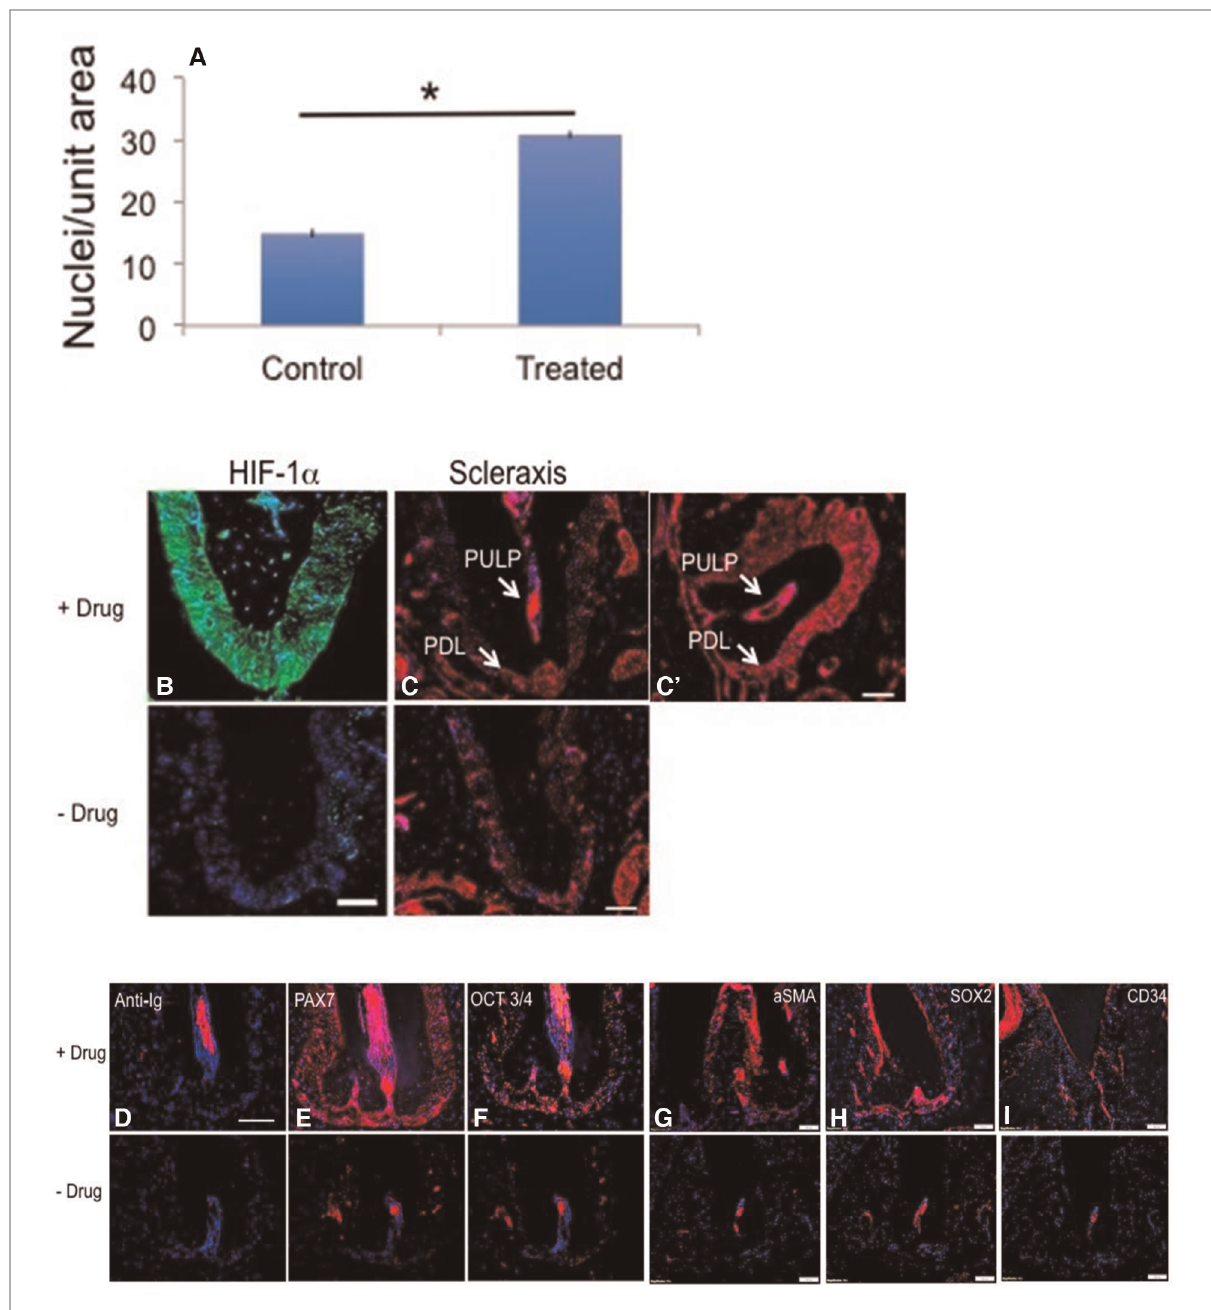
FIGURE 4 Stem cell marker expression in PDL after ligature and drug-treatment. In fi gure, PDL analysis was carried out in B6-treated mice. In ( A ), in B6 mice, the number of PDL fi broblast nuclei were counted from Figures 2Bc,Cc and are two-fold greater in the drug-treated B6 mice. The Y -axis is the number of nuclei/unit area; error bars are standard errors; n =4; * p <0.01. In (B,C,C') , longitudinal jaw cross-sections from ligated-plus-drug (upper panels) vs. ligated only (lower panels) respectively were stained with antibody to HIF-1 α (green) and scleraxis (red) with PDL staining levels higher in sections from drug-treated vs. no drug mice (for scleraxis, 11% vs. 4% red pixels; as described in Figure 3 ) ( C ). The scale bar=100 um. In ( E – I ), antibodies to the stem cell or de-differentiation markers PAX7, OCT3/4, aSMA, SOX2, and CD34 stained more highly in the drug-treated PDL (upper panels) compared to the non-drug treated PDL (lower panels). Anti-Ig controls showed no staining in the PDL except in the root canal ( D ). The scale bar=100 um for all photomicrographs except Fig 4d where the scale bar=200